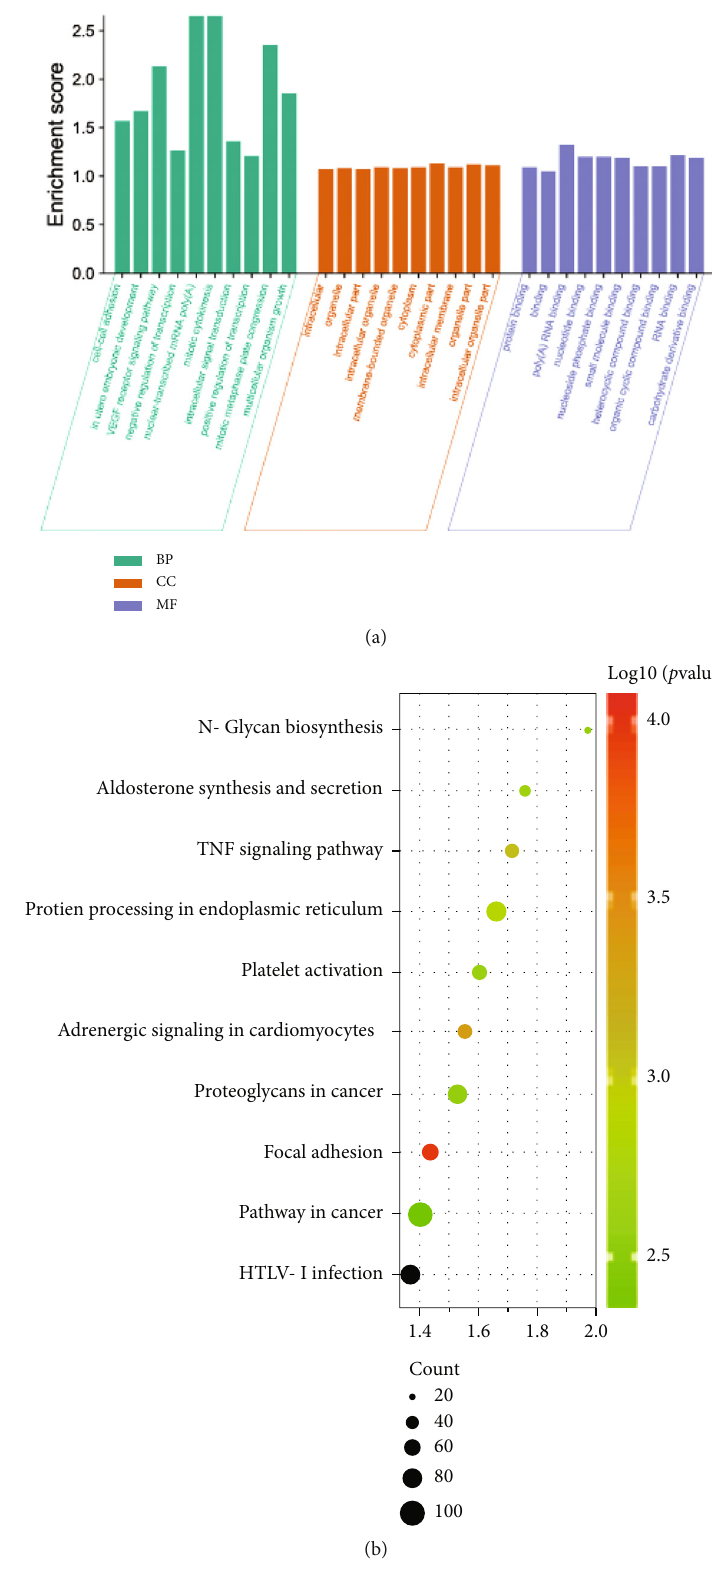
Figure 2: GO analysis and KEGG enrichment analysis. (a) GO enrichment analysis of di ff erentially expressed genes, including biological processes, cellular components, and molecular functions; (b) KEGG pathway enrichment skin run map of related